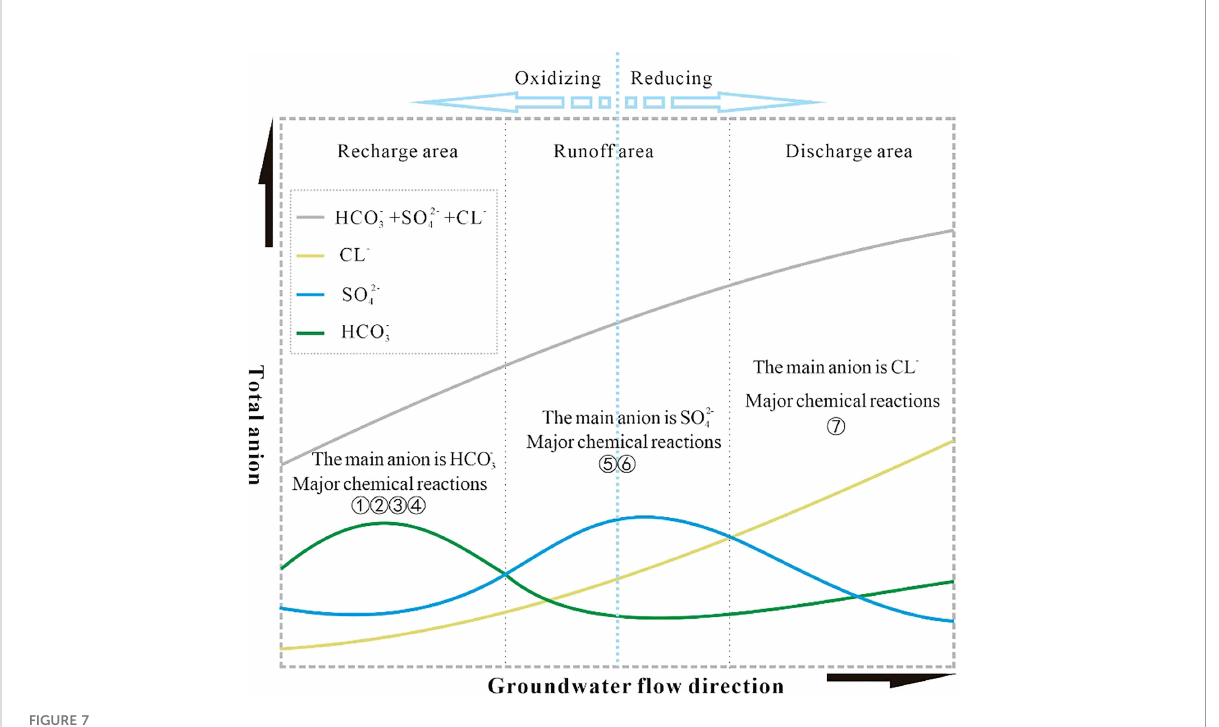
FIGURE 7 Schematic diagram of anion evolution in groundwater fl ow